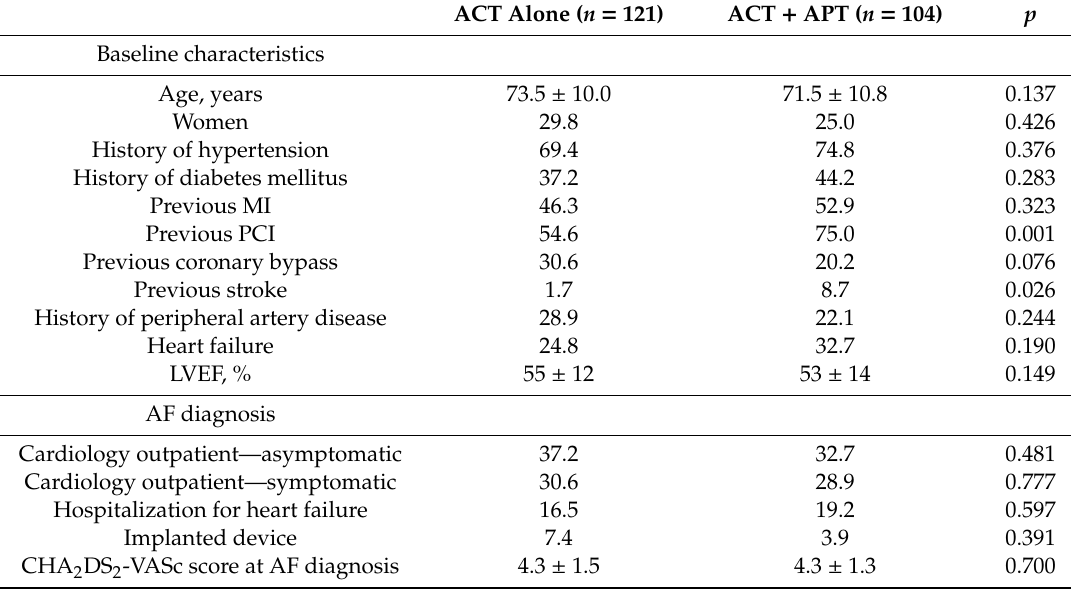
Table 3. Comparison of patients receiving anticoagulant therapy (ACT) alone vs. ACT and antiplatelet therapy (APT) ( n = 225 patients with incident atrial fibrillation (AF) and without a recent ( < 1 year) history of myocardial infarction (MI) or percutaneous coronary intervention (PCI)).